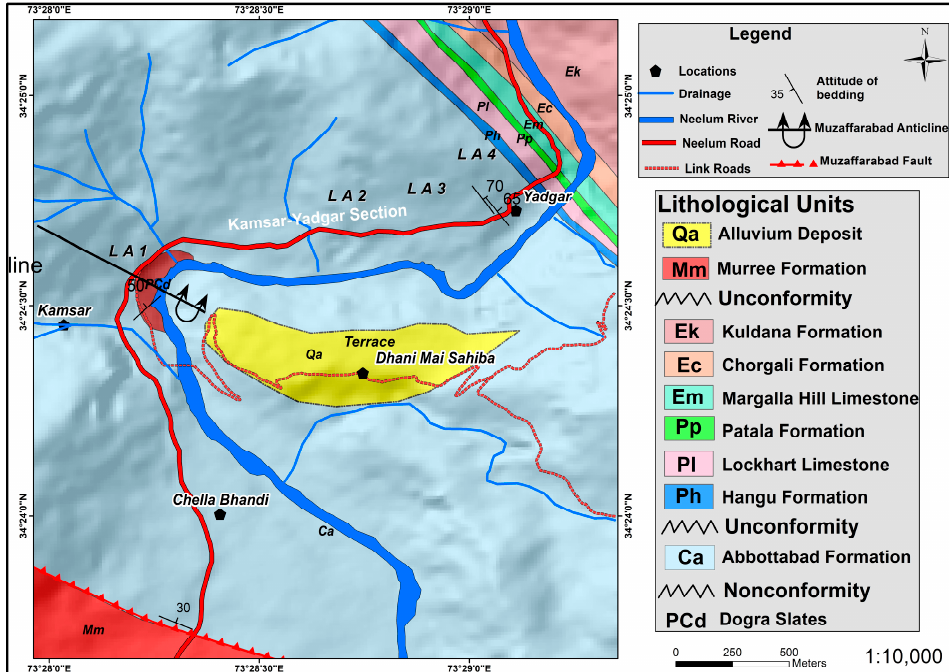
Figure 3. Simplified geological map of the study area.